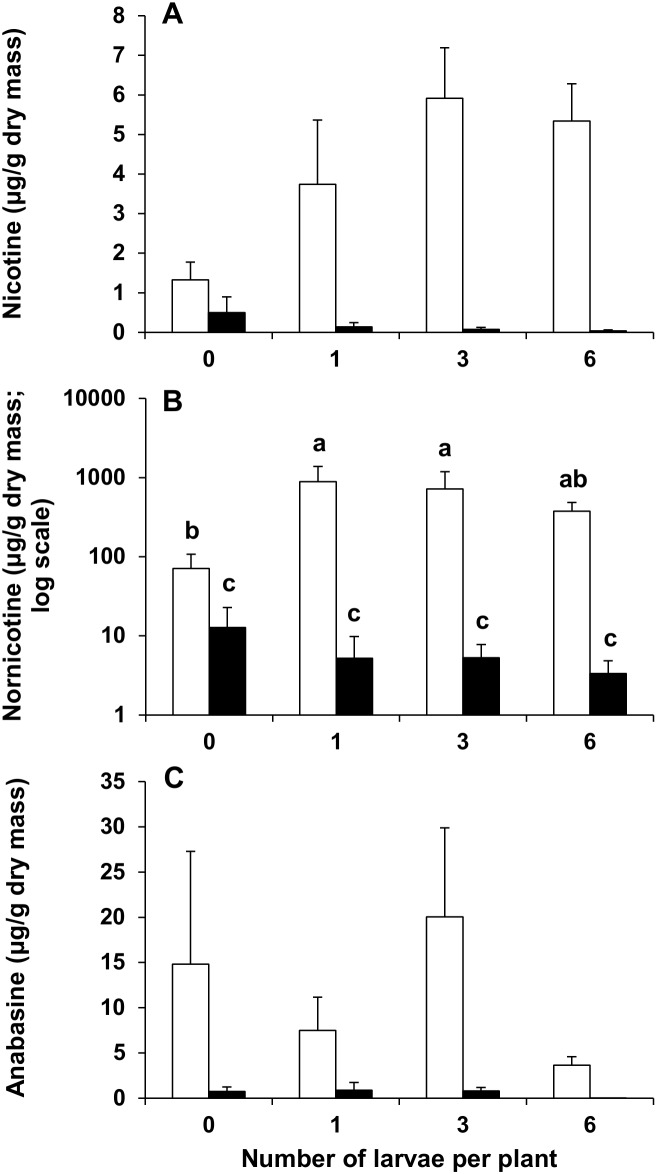
Alkaloid concentrations in undamaged leaves after herbivory.Effect of herbivory by Helicoverpa armigera fourth-instar larvae on (A) nicotine, (B) nornicotine and (C) anabasine concentrations (mean ± SE) in undamaged top (open bars) and undamaged bottom (black bars) leaves of flowering Nicotiana africana. n = 3–8. Same letters above bars indicate no significant differences at P>0.05.